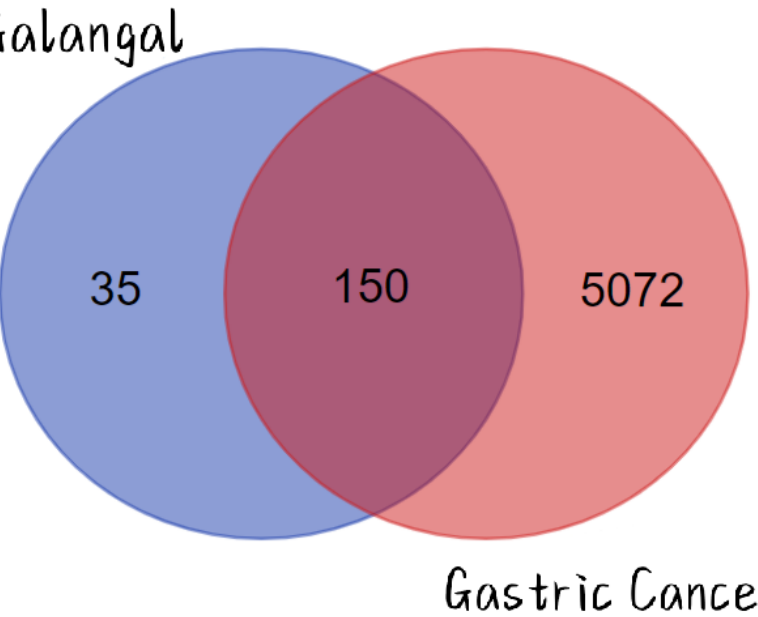
Figure 1. Venn diagram of the effective compounds of galangal and the target genes of gastric can-